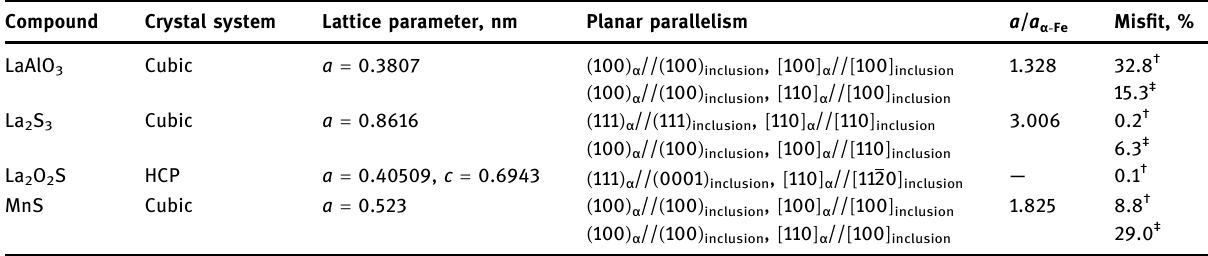
* Lattice parameter of α - Fe a = 0.28665 nm. † Low index orientation relationship between ferrite and inclusion. ‡ Bain orientation relationship between ferrite and inclusion.